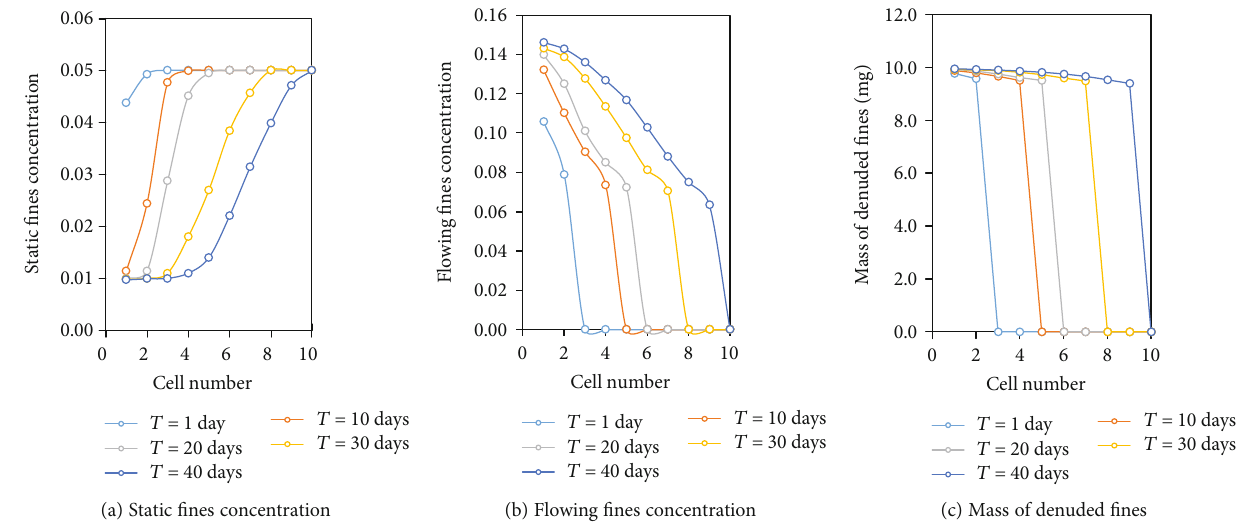
Figure 7: Pro fi les of coal fi nes in the reservoir at 12m 3